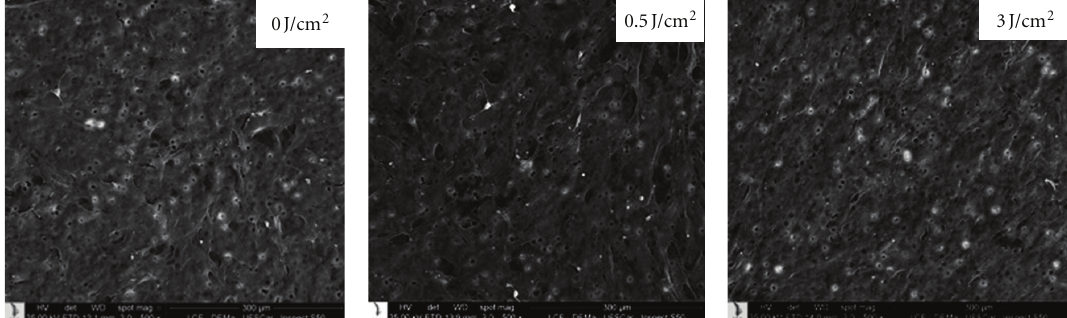
Figure 2: SEM micrograph showing cells with normal morphology that migrated through the transwell membrane. SEM ×